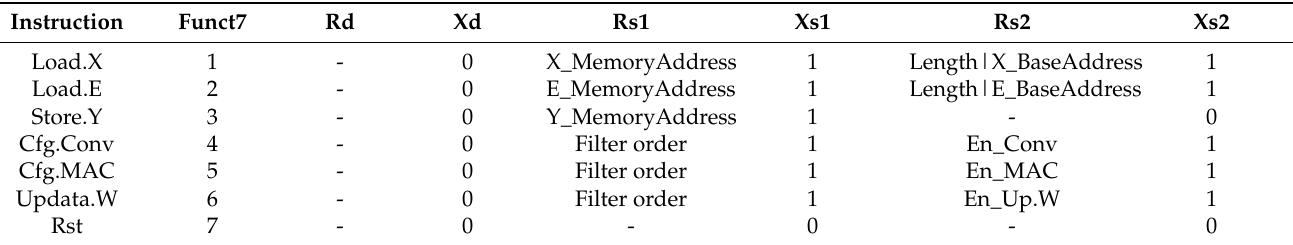
Table 1. Custom instruction table of coprocessor.